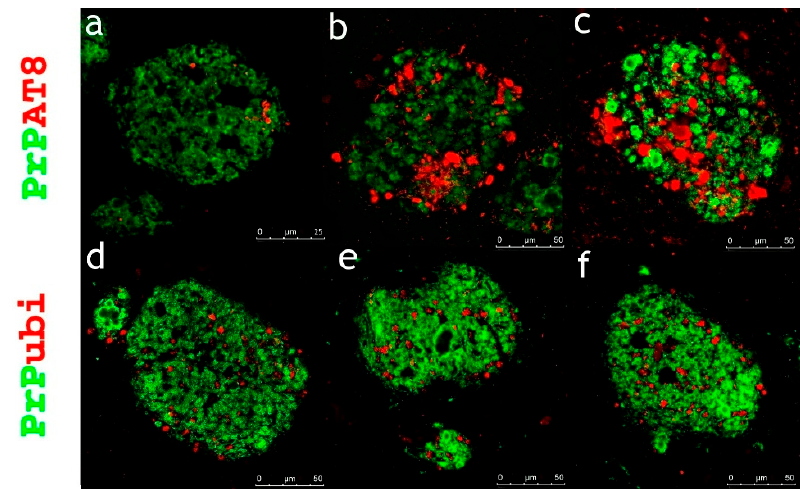
Figure 5. AT8 positive bulbous changes within huge diffuse PrP plaques—Immunofluorescence observation of co-expression PrP with hyperphosphorylated protein tau and ubiquitin in large plaques located in CA1 or the subiculum. ( a ) Large diffuse PrP with no or negligible co-pathology with hyperphosphorylated protein tau in subject no. 4; ( b , c ), significant co-aggregation of PrP with bulbous neurites stained for hyperphosphorylated protein tau in subject no. 7; ( d – f ), and significant co-aggregation of PrP with dystrophic neurites stained for ubiquitin in subject no. 4. Primary antibodies: PrP (rabbit recombinant monoclonal antibody, green color), AT8 (mouse monoclonal antibody, red color), ubiquitin (mouse monoclonal antibody, red color). The secondary antibody was conjugated with either Alexa Fluor ® 488 (anti-rabbit IgG, green) or Alexa Fluor ® 568 (anti-mouse IgG, red). Scale bars indicate 25 µ m in ( a ), and 50 µ m in ( b – f